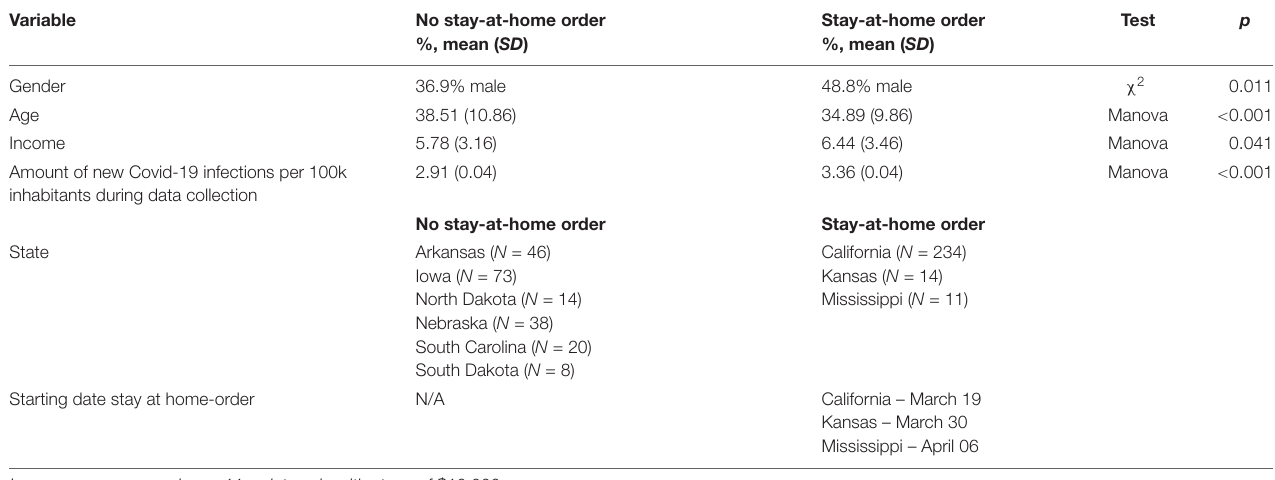
TABLE 1 | Differences in demographics between states with or without a stay-at-home order.